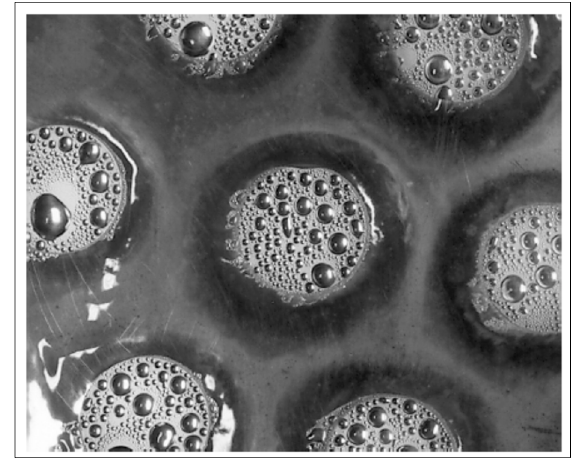
Figure 7. Dropwise condensation on coated and filmwise condensation on uncoated portions of the same substrate [76]. Reprinted with permission from Ref. [76]. Copyright 1997 Springer.